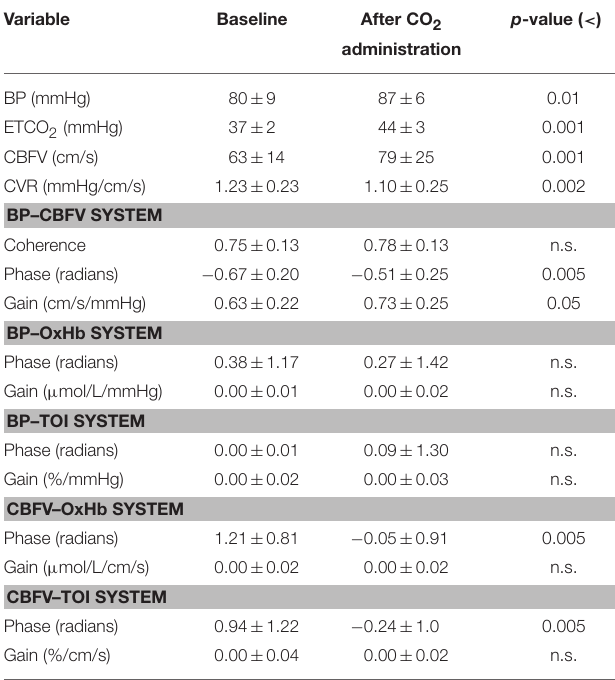
TABLE 1 | Physiological variables and transfer function parameters in the 0.07–0.15 Hz range in different systems at baseline and after CO 2